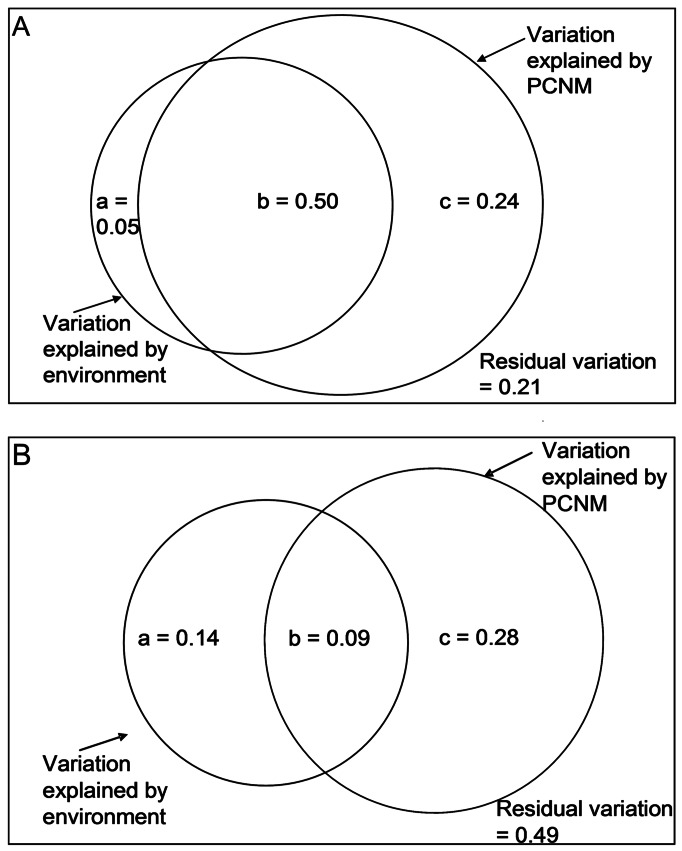
Variation partitioning results.Venn diagrams represent the partitioning variation in the archaeal community (beta- diversity) in different habitats (A) non-flooded soil (NS) and (B) flooded soil (FS). Each box represented 100% of the variation in the corresponding response variable, and the reported fractions were adjusted R2 statstics (Ra2).